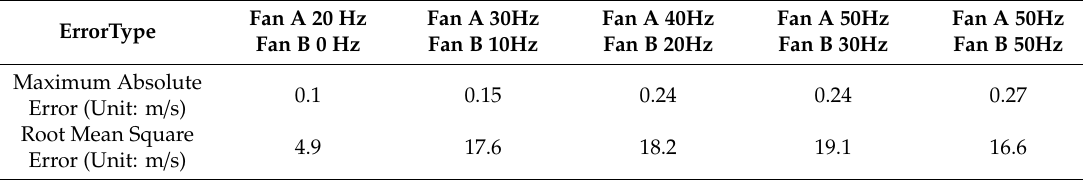
Table 5. Error values under di ff erent working